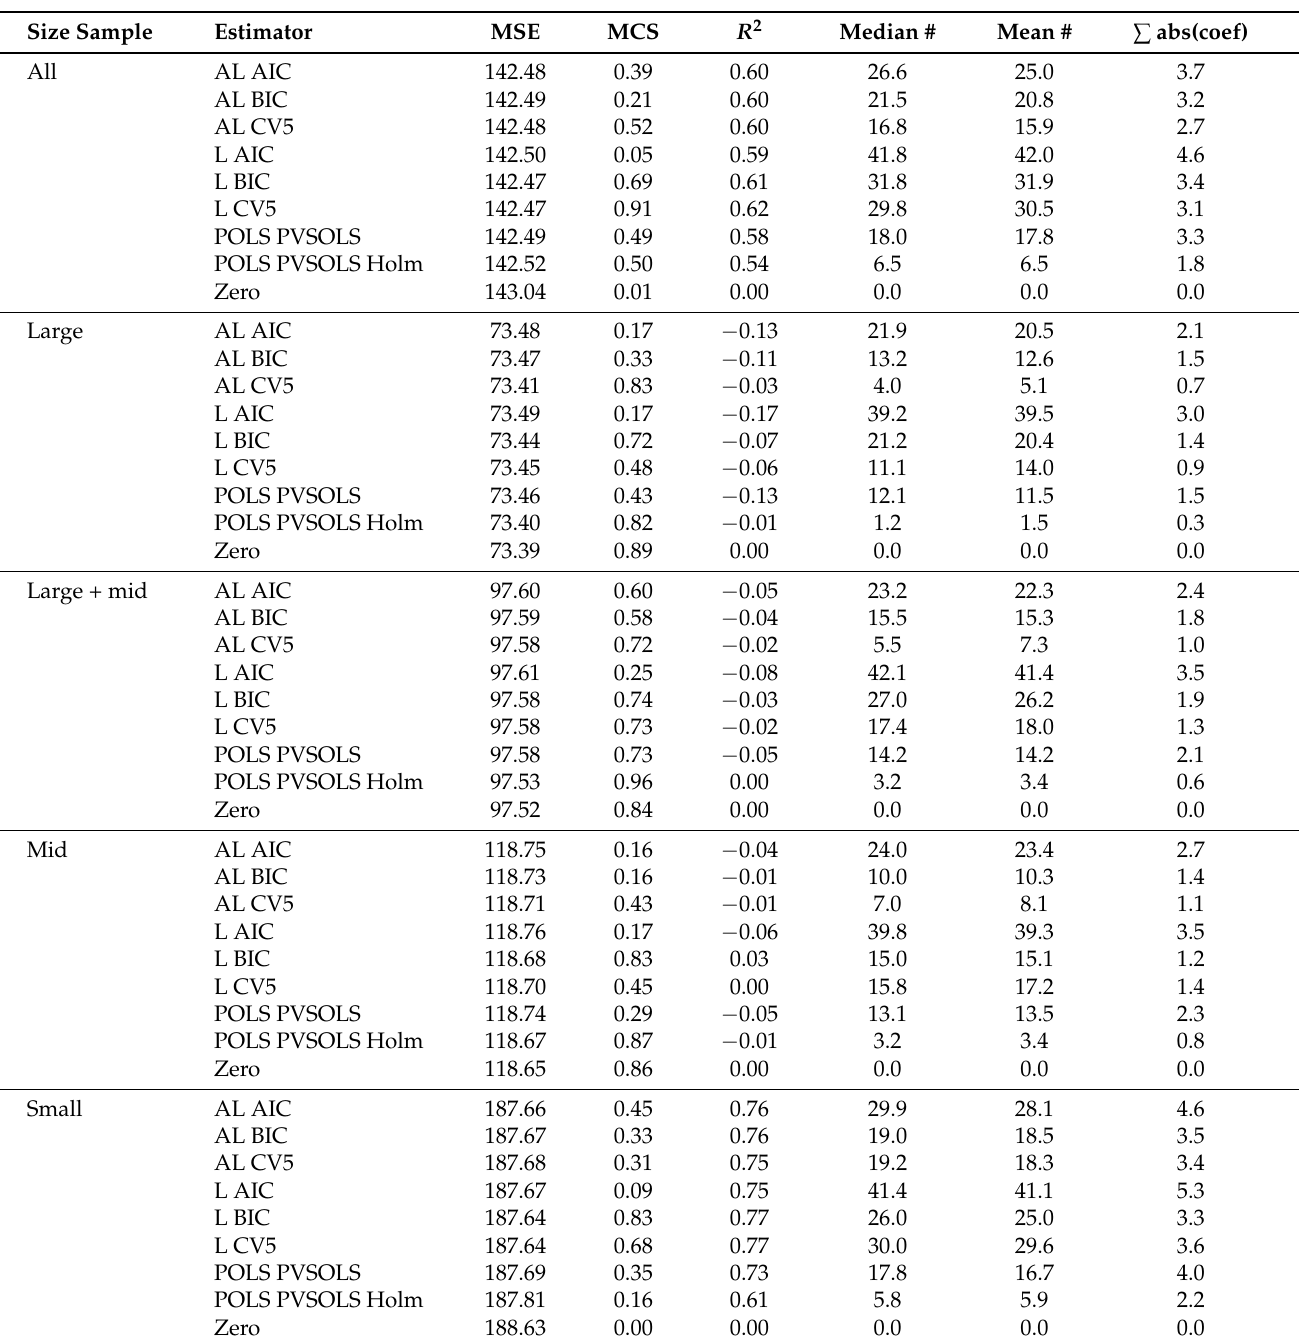
Table 2. Out-of-Sample Forecast Evaluation: The MSE and R 2 s are calculated according to (7)–(8). The MCS indicates the p -value of being part of the set that includes the best model. The monthly R 2 s are expressed in percentage points. The MSE and ∑ abs(coef) column values are scaled by a factor of 10 3 and 10 1 , respectively. The columns “Median #” and “Mean #” show the time-series median and mean of the number of active